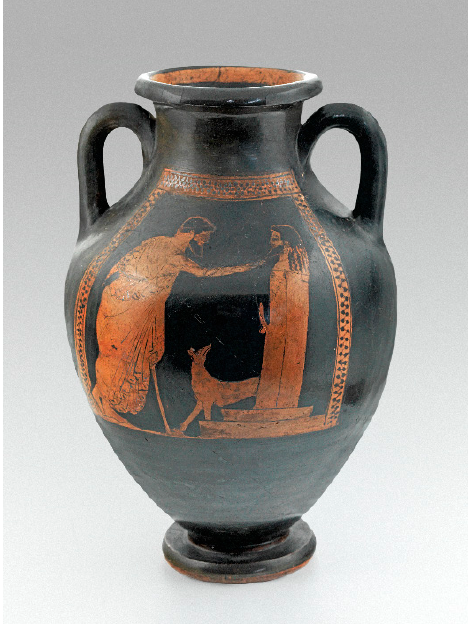
Figure 4. Bearded man with dog in front of ithyphallic herm (APM inv. no. 14.225); amphora; Table 500. Photo by Stefan van der Linden; image courtesy of the Allard Pierson Museum, Amsterdam.